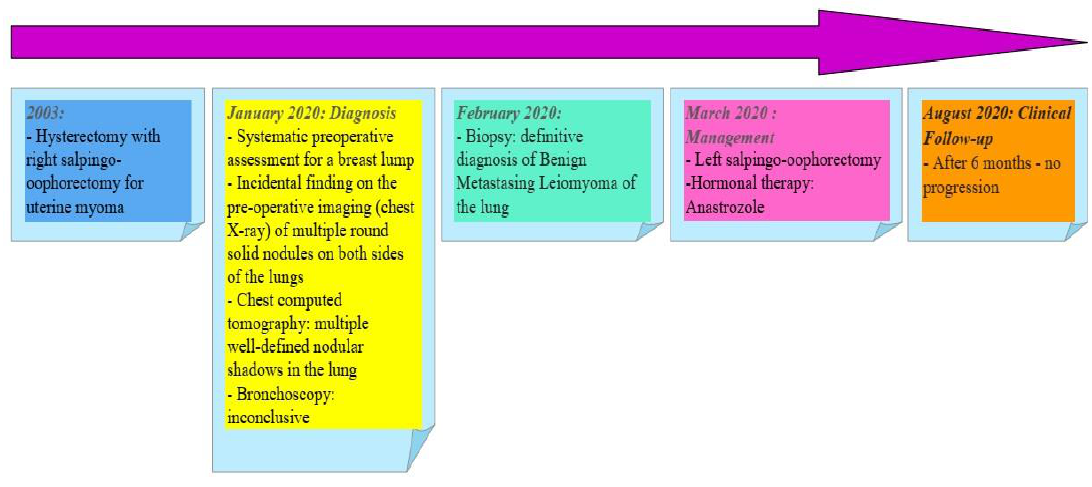
Figure 3: Timeline of the patient